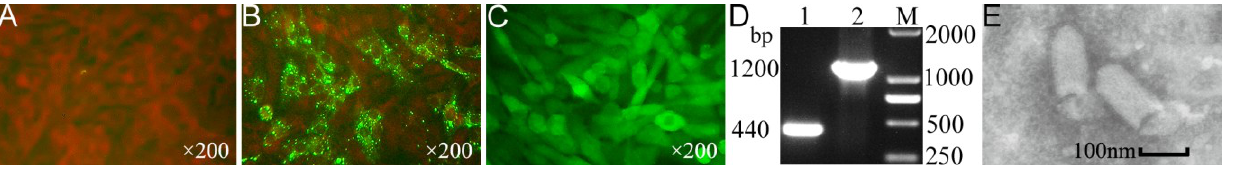
Figure 2. Identification of the recombinant RABV rCVS-11-eGFP strain. ( A )